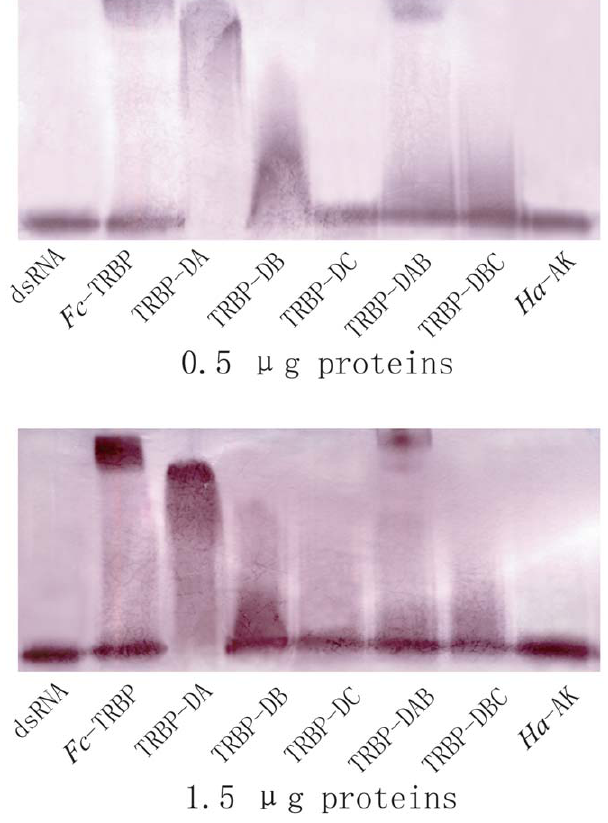
Figure 4. Gel-shift assays that identify the dsRNA-binding activity of recombinant dsRBDs of Mj -TRBP and full length recombinant TRBP 0.5 m g (up) and 1.5 m g (down) protein were incubated with 2.5 m g 193-bp dsRNA. Ha -AK served as the